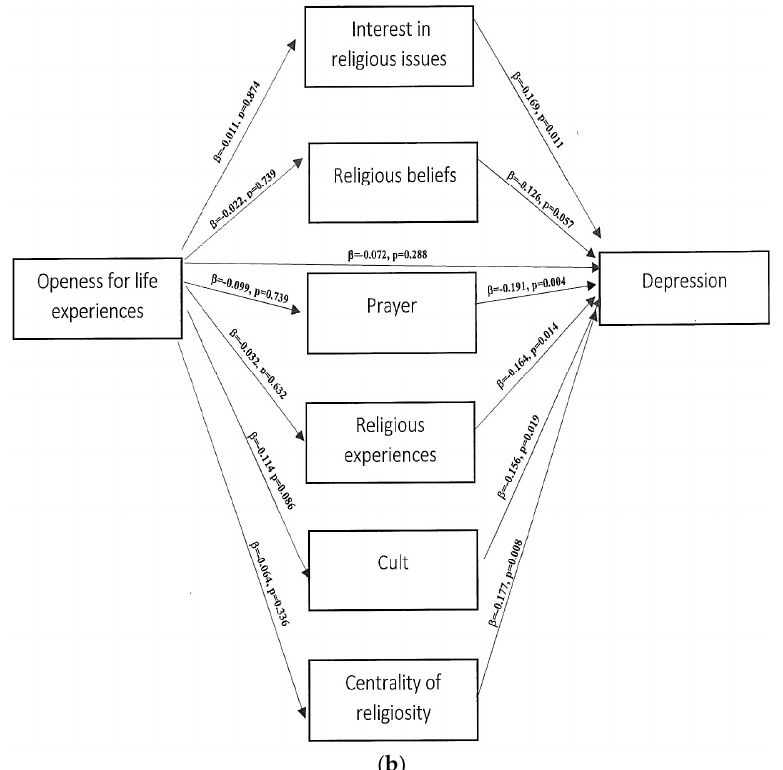
Figure 2. ( a , b ) Path analytical model of the inter-relationship between the study variables ego- resiliency, religiosity, and depression.